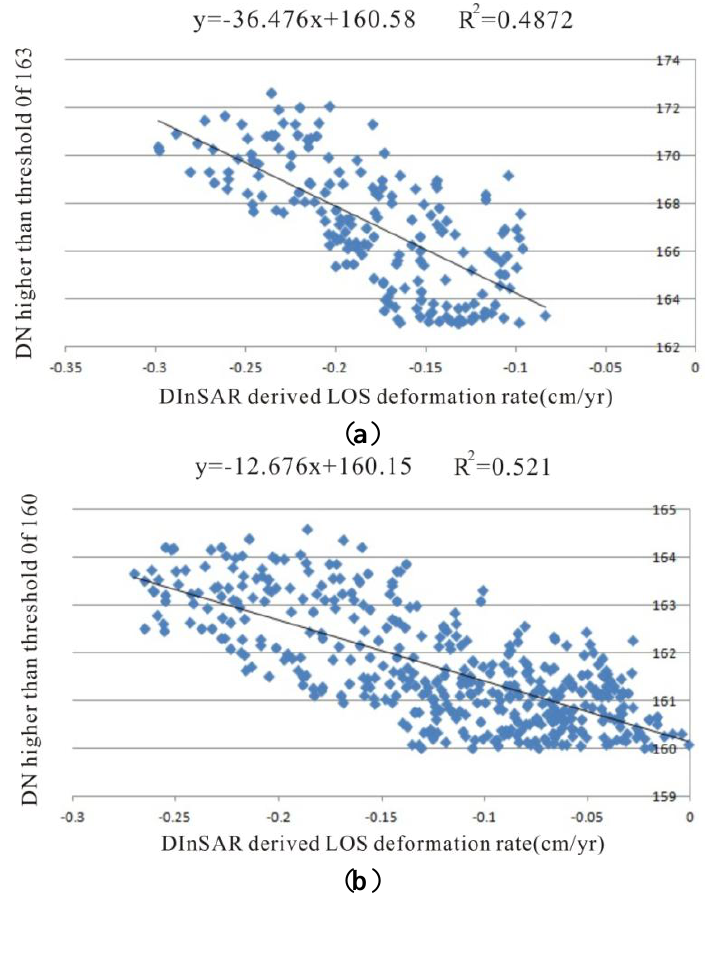
Figure 11. ( a ) A cross-plot between the displacement velocities of pixels and their corresponding average digital numbers (DN) higher than the threshold of 163 that were regarded as thermal anomalies in coal fire zone 11. ( b ) A cross-plot between the displacement velocities of pixels and their corresponding average digital numbers (DN) higher than the threshold of 160 that were regarded as thermal anomalies in coal fire zone